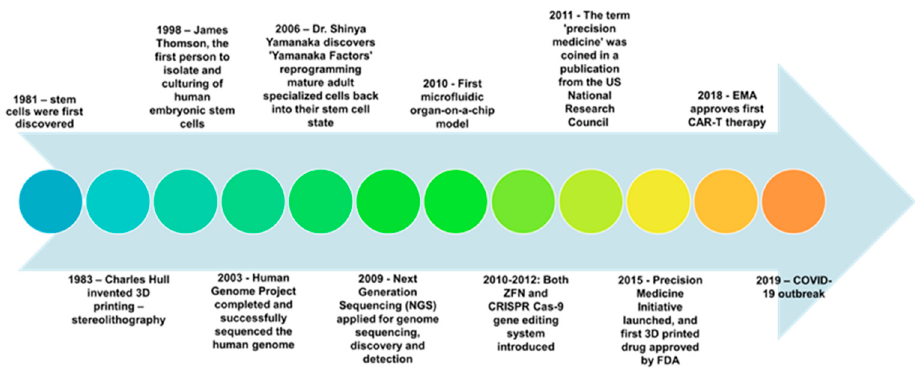
Figure 1. A brief timeline of major scientific discoveries and events [5–17].